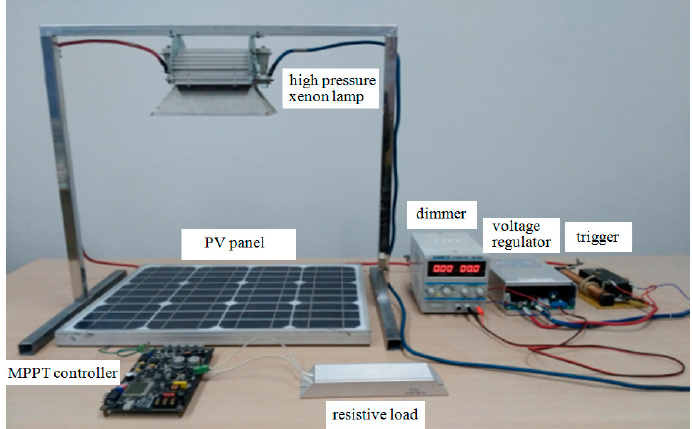
Figure 8. Arrangement of the PV panels.